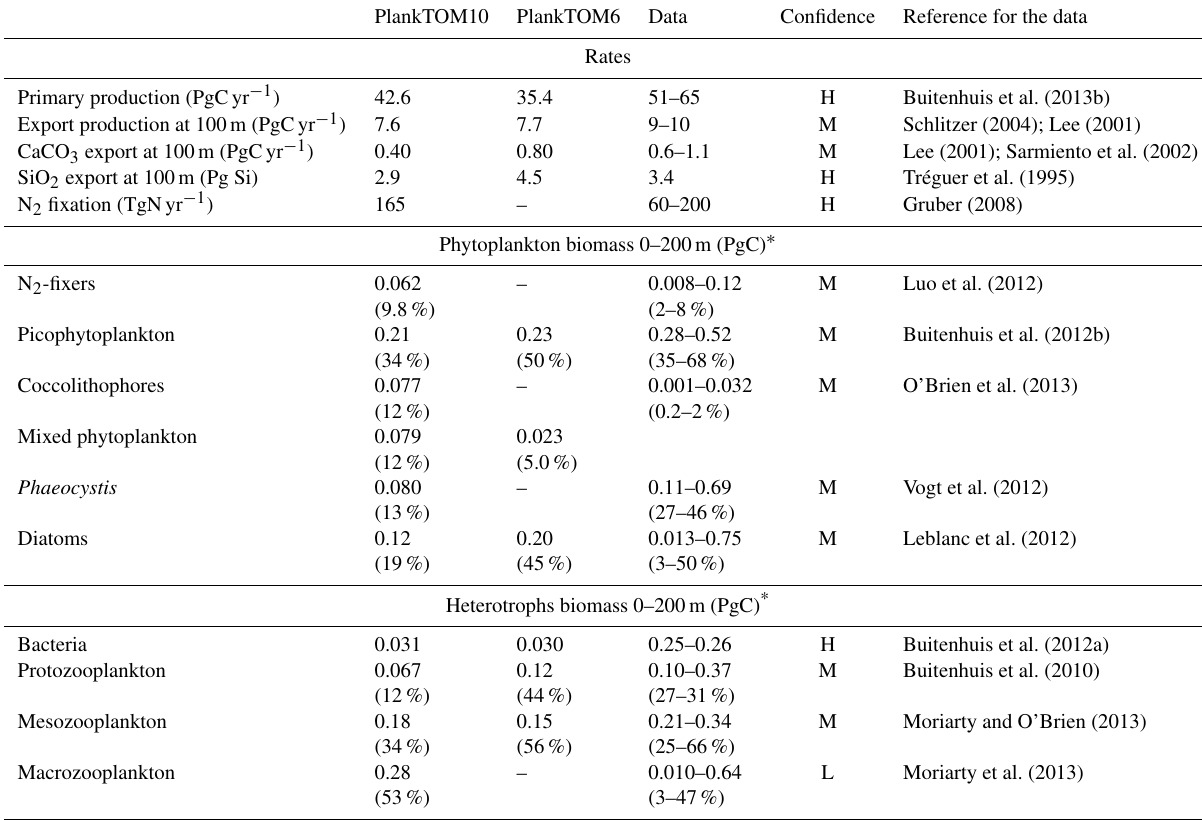
Table 4. Global mean values for rates and biomass from observations (data) and the PlankTOM10 and PlankTOM6 models averaged over 1998–2009. The reported confidence levels refer to the observations and are from the author’s assessment of confidence with high (H): most likely within ± 25% of reported value; medium (M): most likely within ± 50% of reported value; low (L): could be more than ± 50% of the reported value. For the biomass of phytoplankton and zooplankton, the percentage of the total biomass is also indicated in parentheses (excluding mixed phytoplankton, for which no observations are